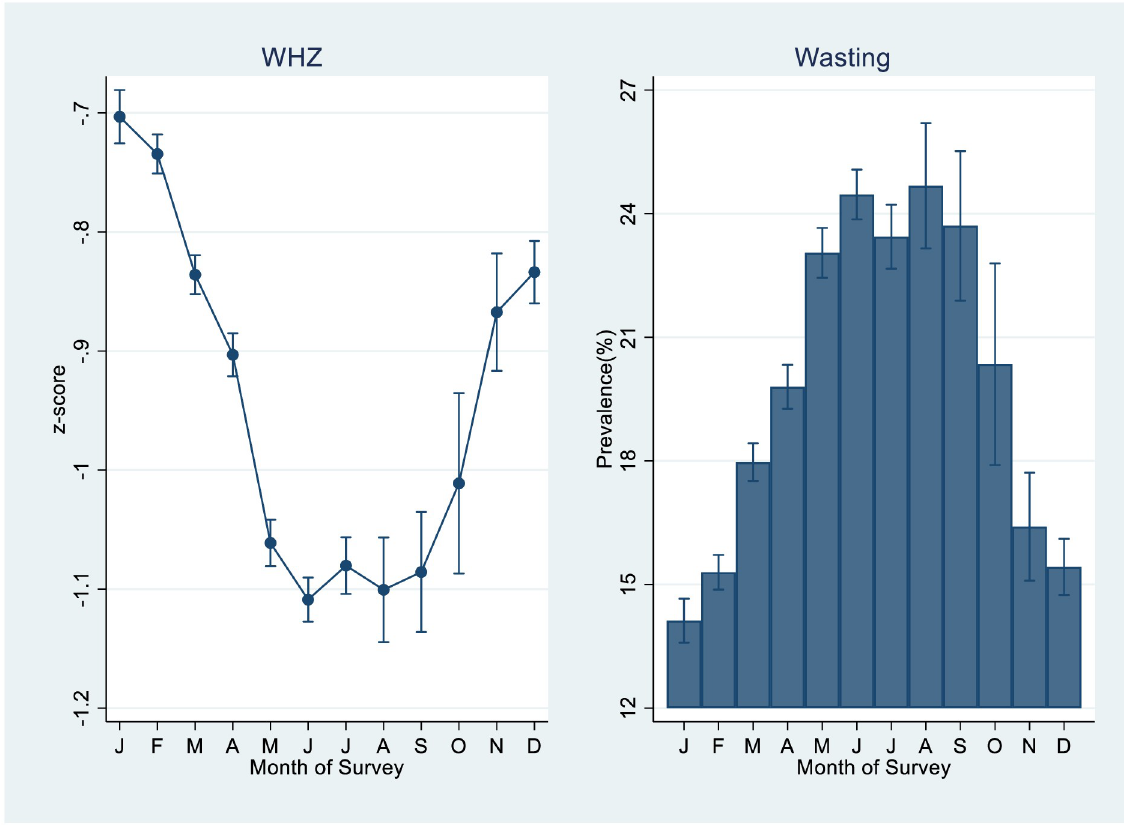
Fig 2. Estimated mean WHZ and prevalence of wasting by month of survey from pooled data of four surveys.